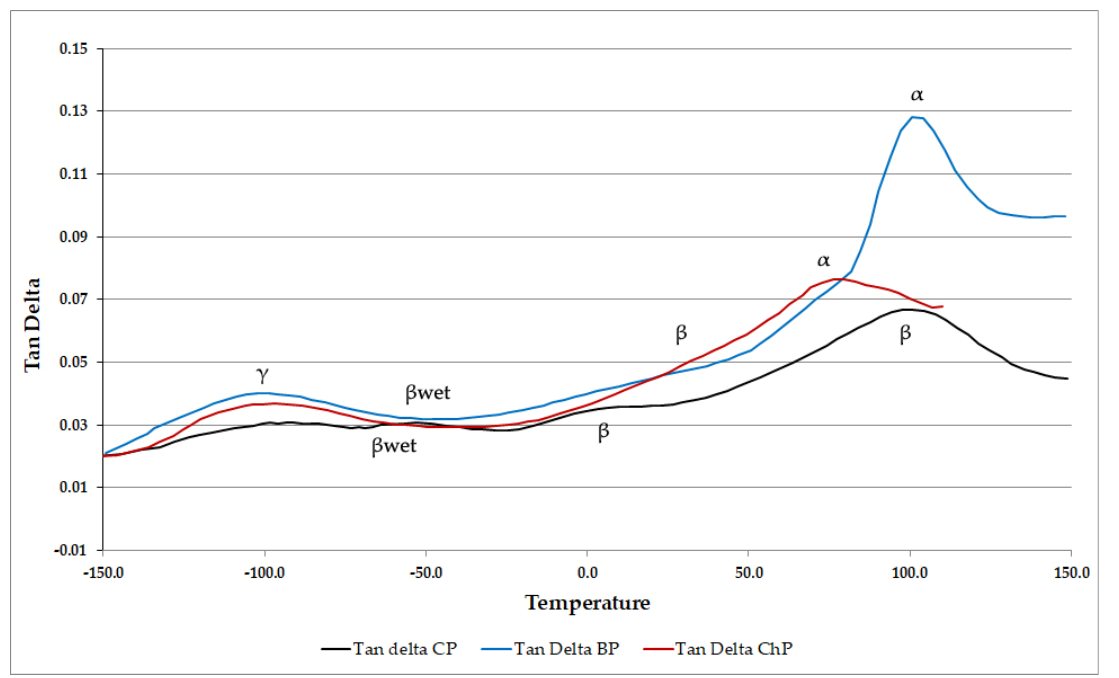
Figure 4. Comparison of loss factor (tan delta) exemplary graphs for contemporary pine: undegraded (CP), biologically degraded (BP) and chemically degraded (ChP) with specific tan delta peaks marked.